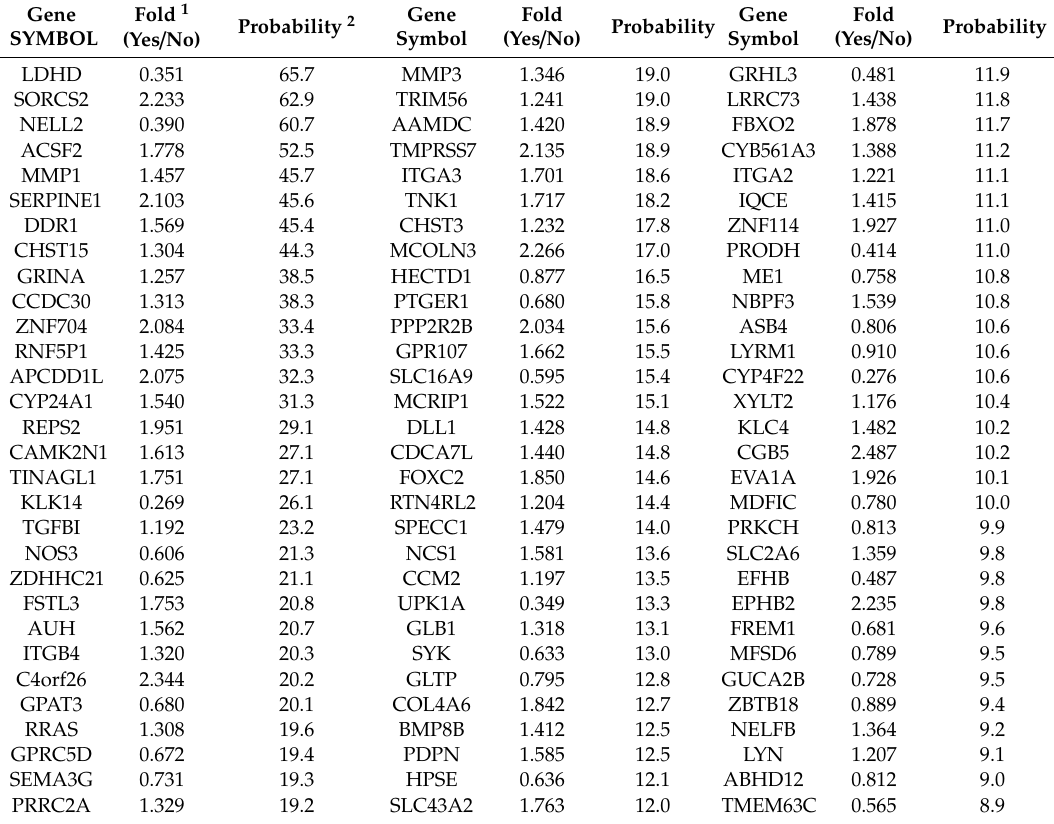
Table A1. Top 90 genes di ff erentially expressed between ALI-Yes and ALI-No identified by Limma topTable function.